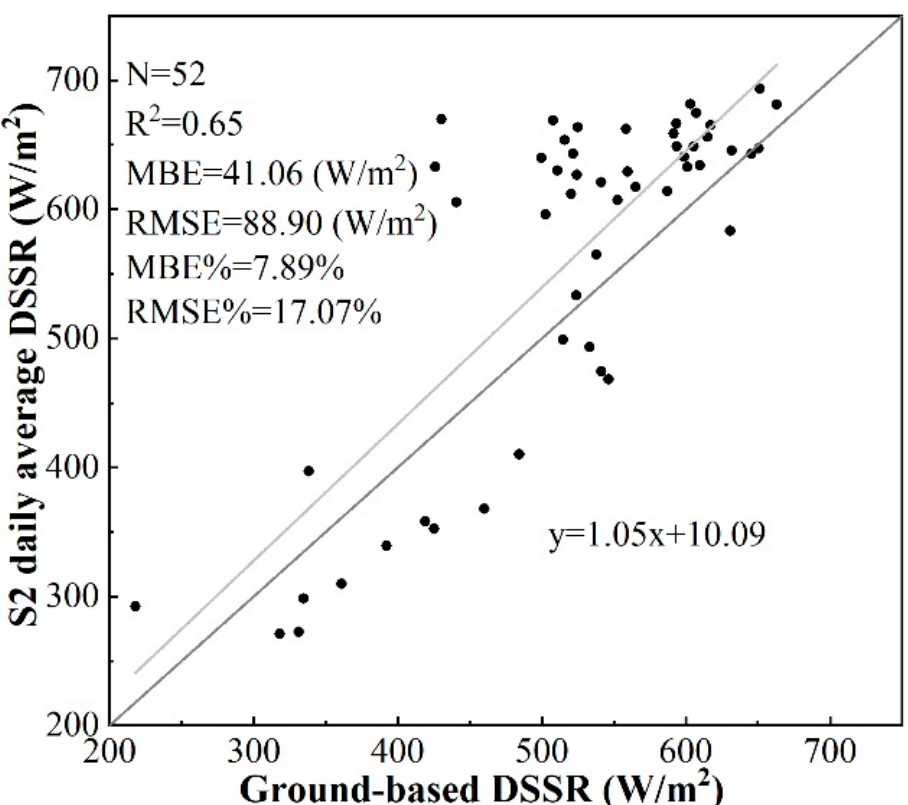
Figure 5. Scatterplots of the daily average DSSR estimated by the sinusoidal model vs. the corre- sponding ground-based measurements obtained from the LHG.